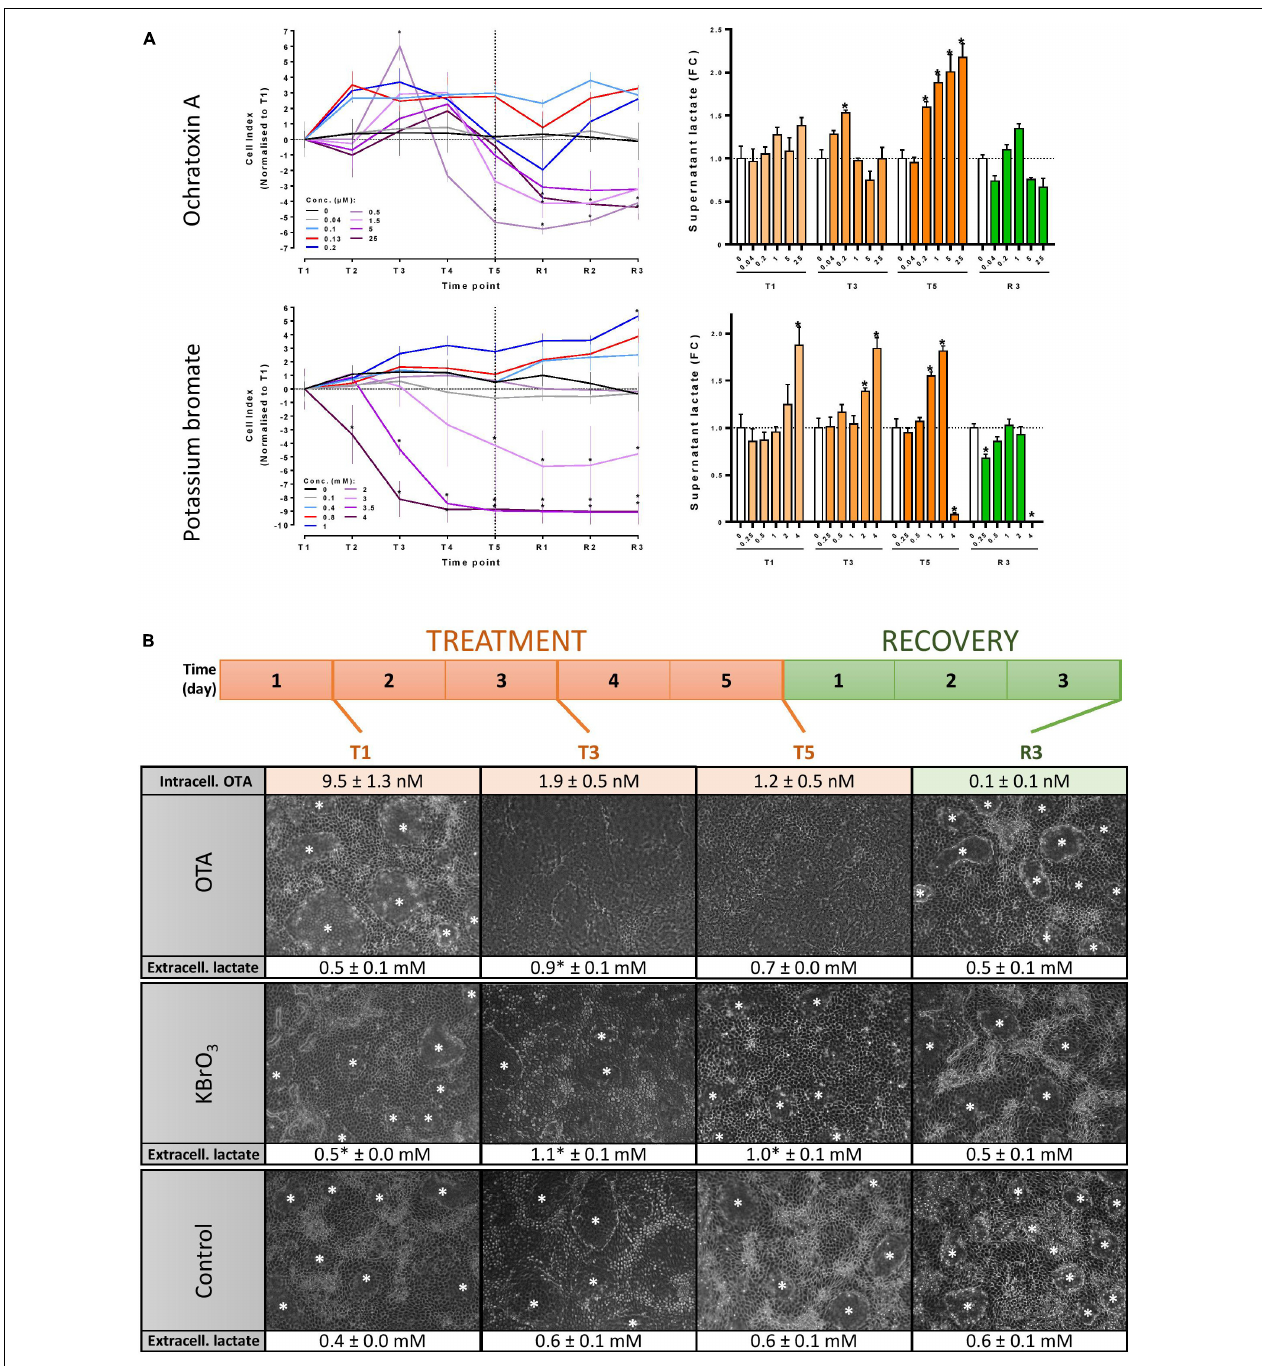
FIGURE 1 | Experimental design optimisation. (A) Concentration range testing in 96-well plates: Mature RPTEC/TERT1 cells were exposed to up to 25 µ M OTA, 4 mM KBrO 3 or a vehicle control for 5 days (T5) and fed a further 3 days with medium (R3). Cell viability was assessed by measuring impedance and calculating cell index (CI) with the xCELLigence device. Cellular stress was assessed by measuring supernatant lactate. Significance of change compared to time-matched control in a minimum of 3 biological replicates was assessed with a two-way ANOVA followed by a Bonferroni posttest. ∗ p ≤ 0.05. T1, T2, T3, T4, T5: days 1, 2, 3, 4, and 5 of treatment, respectively. R1, R2, R3: days 1, 2, and 3 of recovery post-treatment. (B) Experimental design for the omic study. Mature RPTEC/TERT1 cells monolayers were treated every 24 h for 5 days with 130 nM OTA, 0.8 mM KBrO 3 or a vehicle control. The treatment was followed by a 3-day recovery period with 24h-feeding cycles with cell culture medium for all three conditions. Cells were lysed for omic investigations at the 4 indicated time points. Intracellular OTA levels were measured by UPLC-MS at the 4 time points. Cell viability and cell stress were monitored throughout the experiment by microscopic examination (original magnification 100 × ) and lactate measurements in cell culture supernatants. Lactate levels in treated cells were compared to time-matched controls with a two-tailed unpaired Student’s t -test ( ∗ p ≤ 0.05, n = 3). White asterisks ( ∗ ) show domes indicative of vectorial